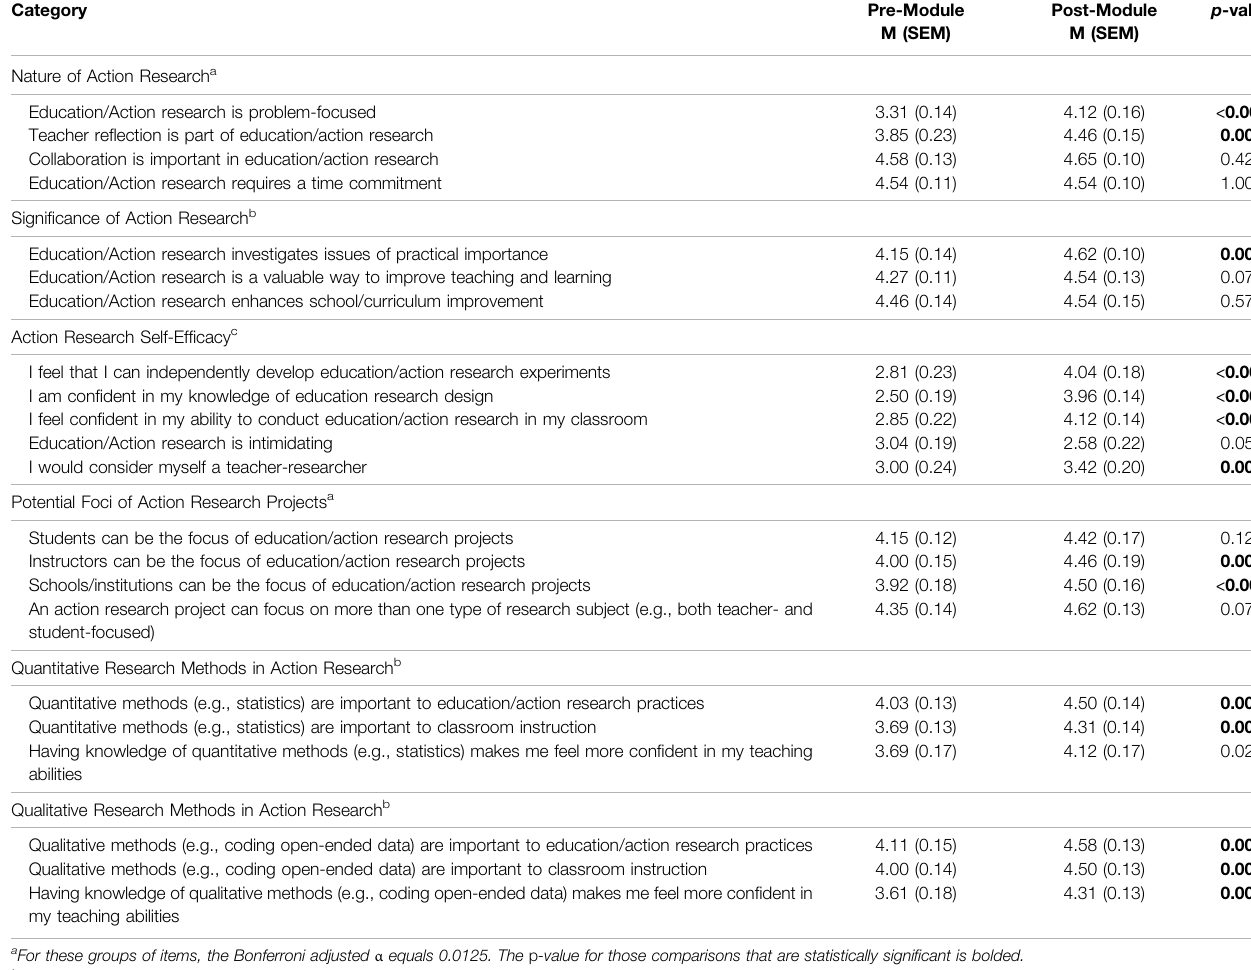
TABLE 4 | Attitudes Toward Education and Action Research (ATEAR) — SALG assessment